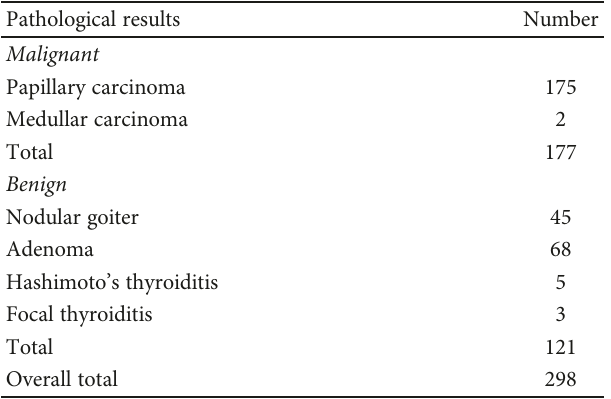
Table 3: Malignancy rate for the TIRADS scoring system.